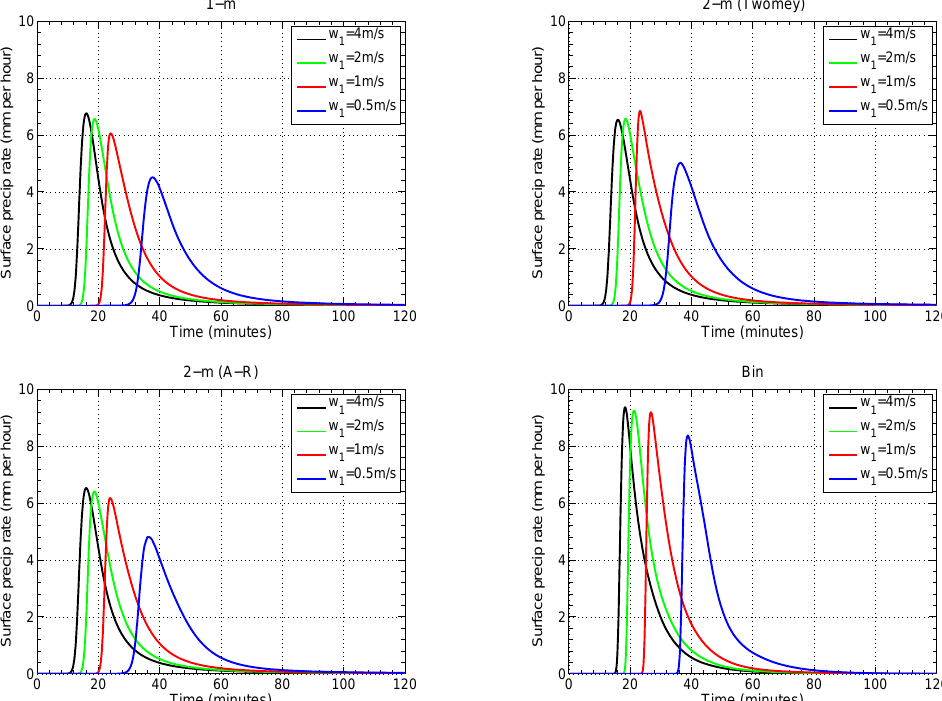
Fig. 7. Timeseries of surface precipitation rates (mm/hr) from each scheme. Clockwise from top left: 1-m, 2-m Twomey, bin, 2-m A-R. Results are shown with CCN=100/cc and T =RICO, for four different values of w 1 .